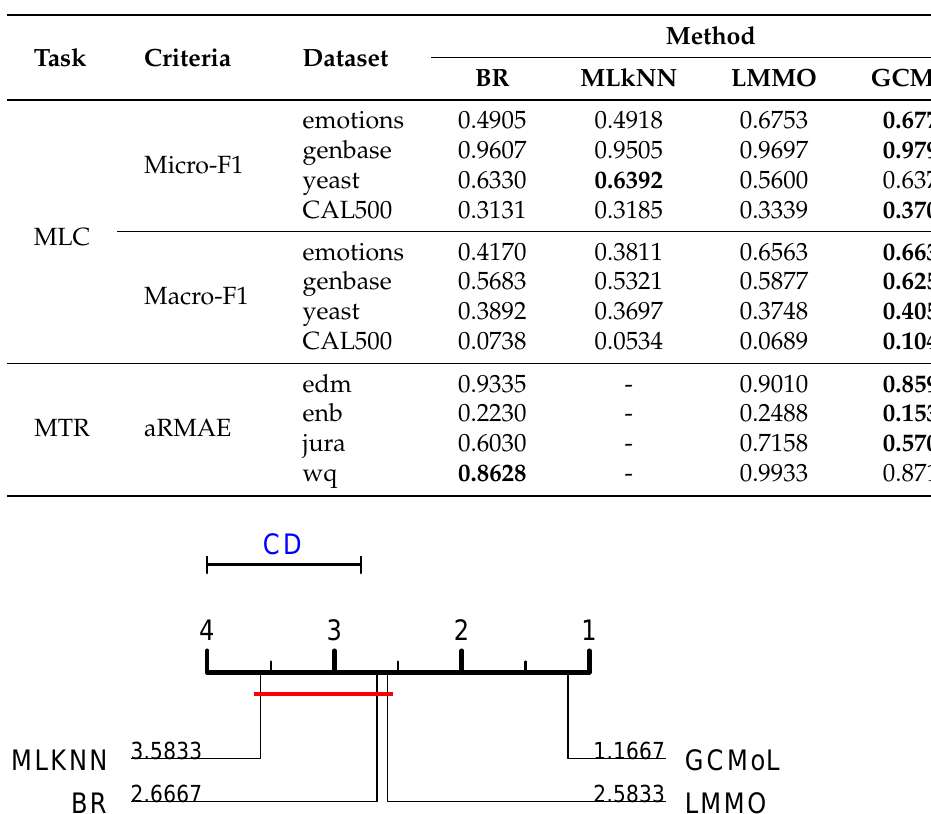
Table 2. Experimental results for multi-output learning. The best ones are in bold.